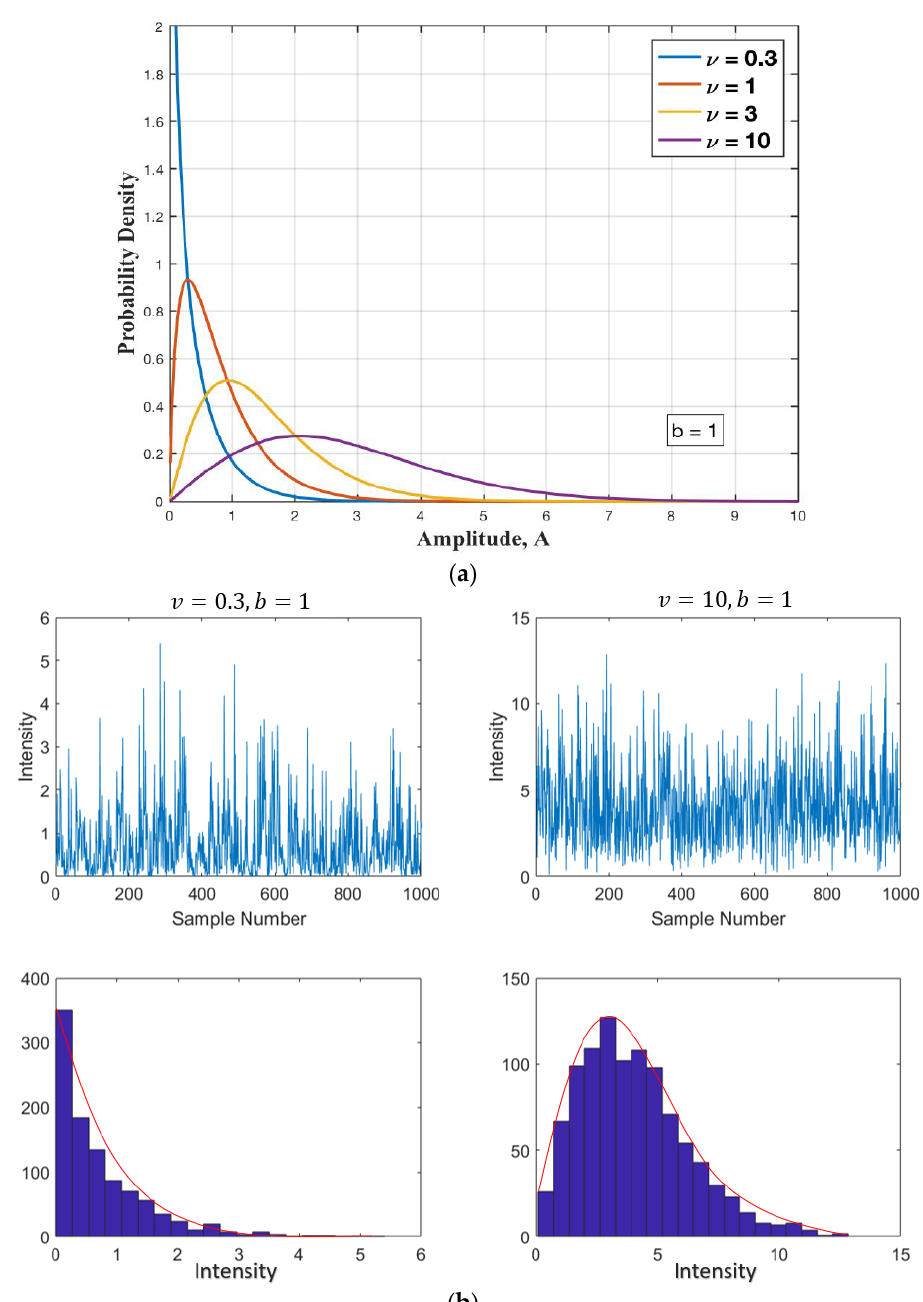
Figure 8. ( a ) CKD amplitude model PDF in Equation (33) for scale parameter b = 1 and for varying 𝑣 ; ( b ) simulation of K-distribution random variates for different values of shape parameter 𝑣 .